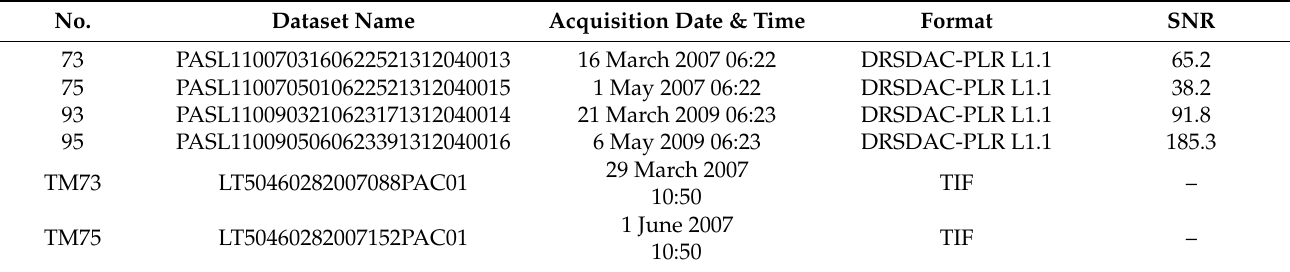
Figure 3. The Pauli decomposition of the four Advanced Land Observing Satellite/Phased Array type L-band Synthetic Aperture Radar (ALOS/PALSAR) data. Table 1. The information of remote-sensing data used in this study.